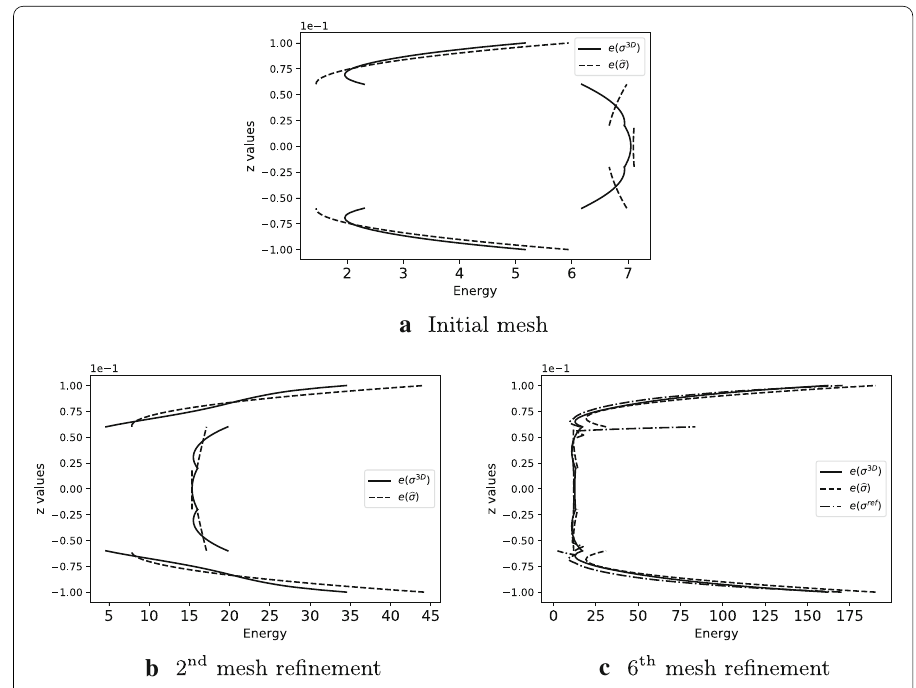
Fig. 8 Energy densities across the plate thickness computed for σ 3 D , (cid:13) σ and σ ref at the plate edge for n = 5